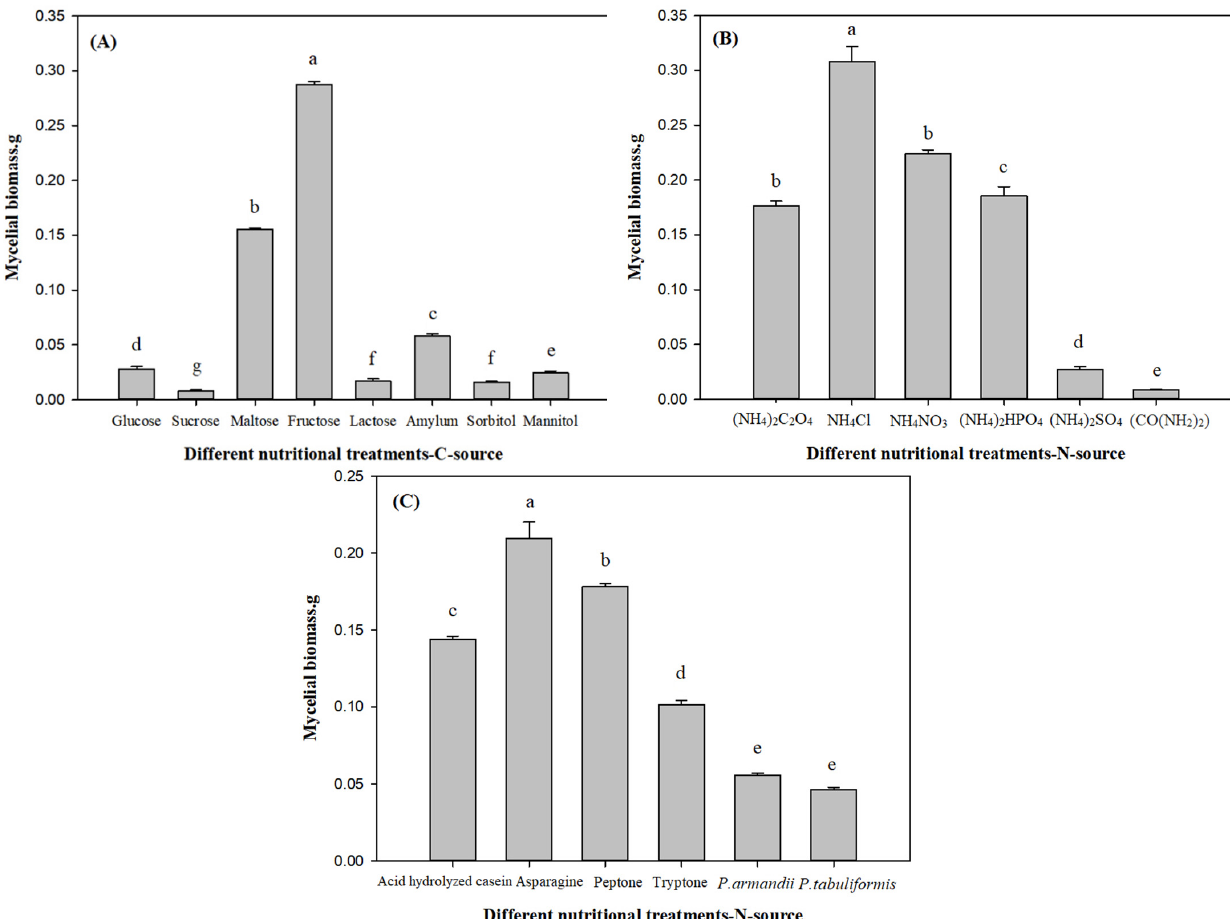
Figure 2. Effects of different nutritional treatments on mycelial biomass. Mycelial biomass is ex- pressed as the mean ± S.E, and the different letters above the bars indicate significant differences ( p < 0.01, Tukey’s HSD test). Eight biological replicates in carbon sources ( A ), 6 biological replicates in inorganic nitrogen sources ( B ), 4 biological replicates in organic nitrogen sources and 2 host nutrition biological replicates ( C ); 5 technical replicates for each biological